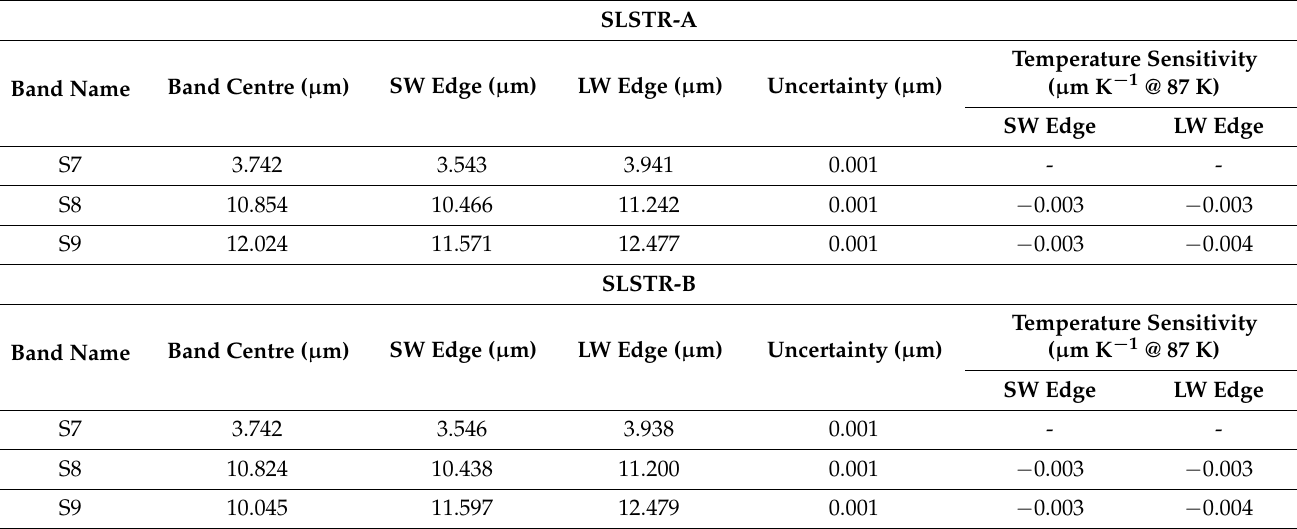
Figure 7. SLSTR-B Spectral Response Measurements for the TIR channels at 87 K [15]. Upper plots give spectral response functions, lower plots the associated systematic uncertainties. Table 8. SLSTR A and SLSTR-B Band Centres, Short and Long Wavelength edges, estimated uncertainties in positions from measurements and temperature sensitivity of the band